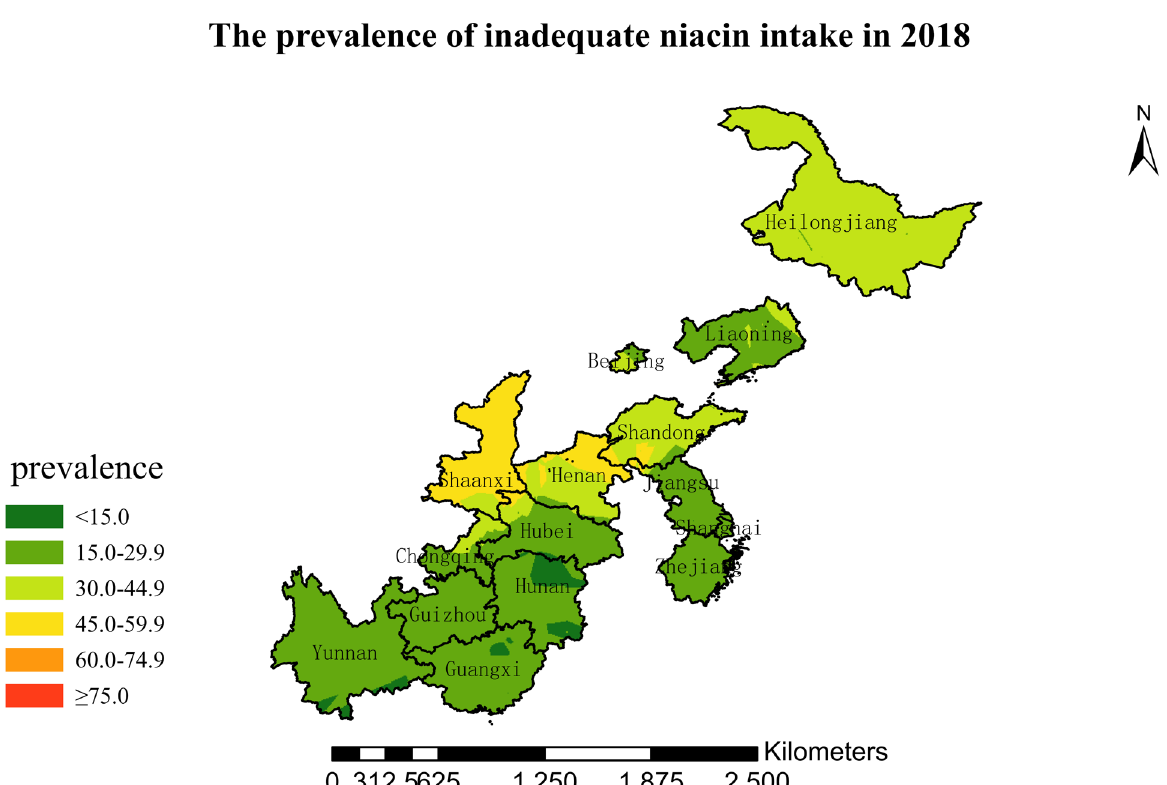
Figure 10. The prevalence of inadequate niacin intake by county in 2018 among Chinese Residents ≥ 5 Years of